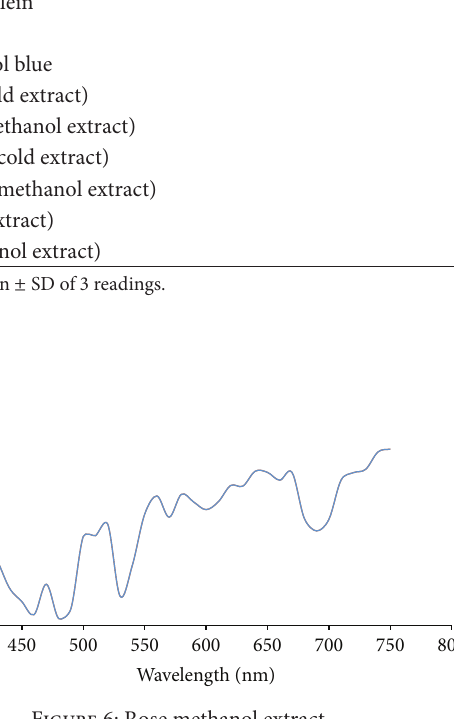
Figure 6: Rose methanol